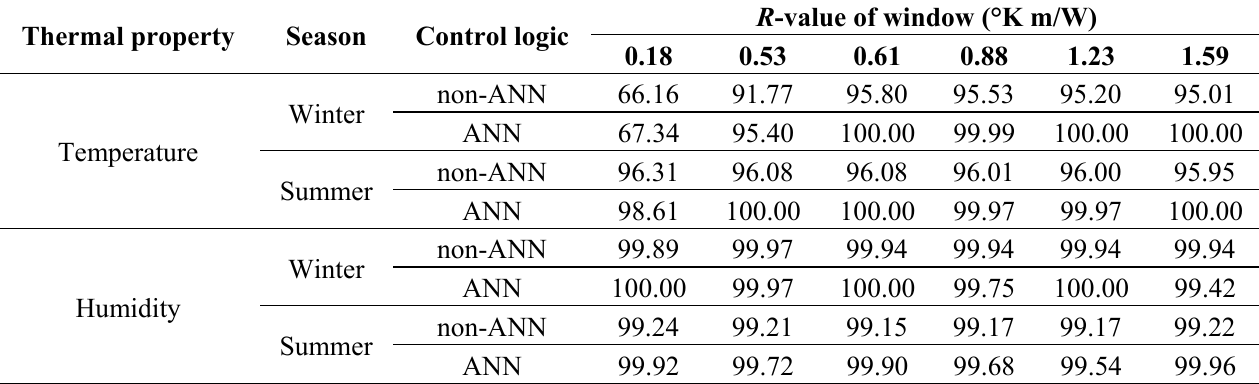
Table 7. Percentage of period within comfortable range according to R -value of window (unit: %).